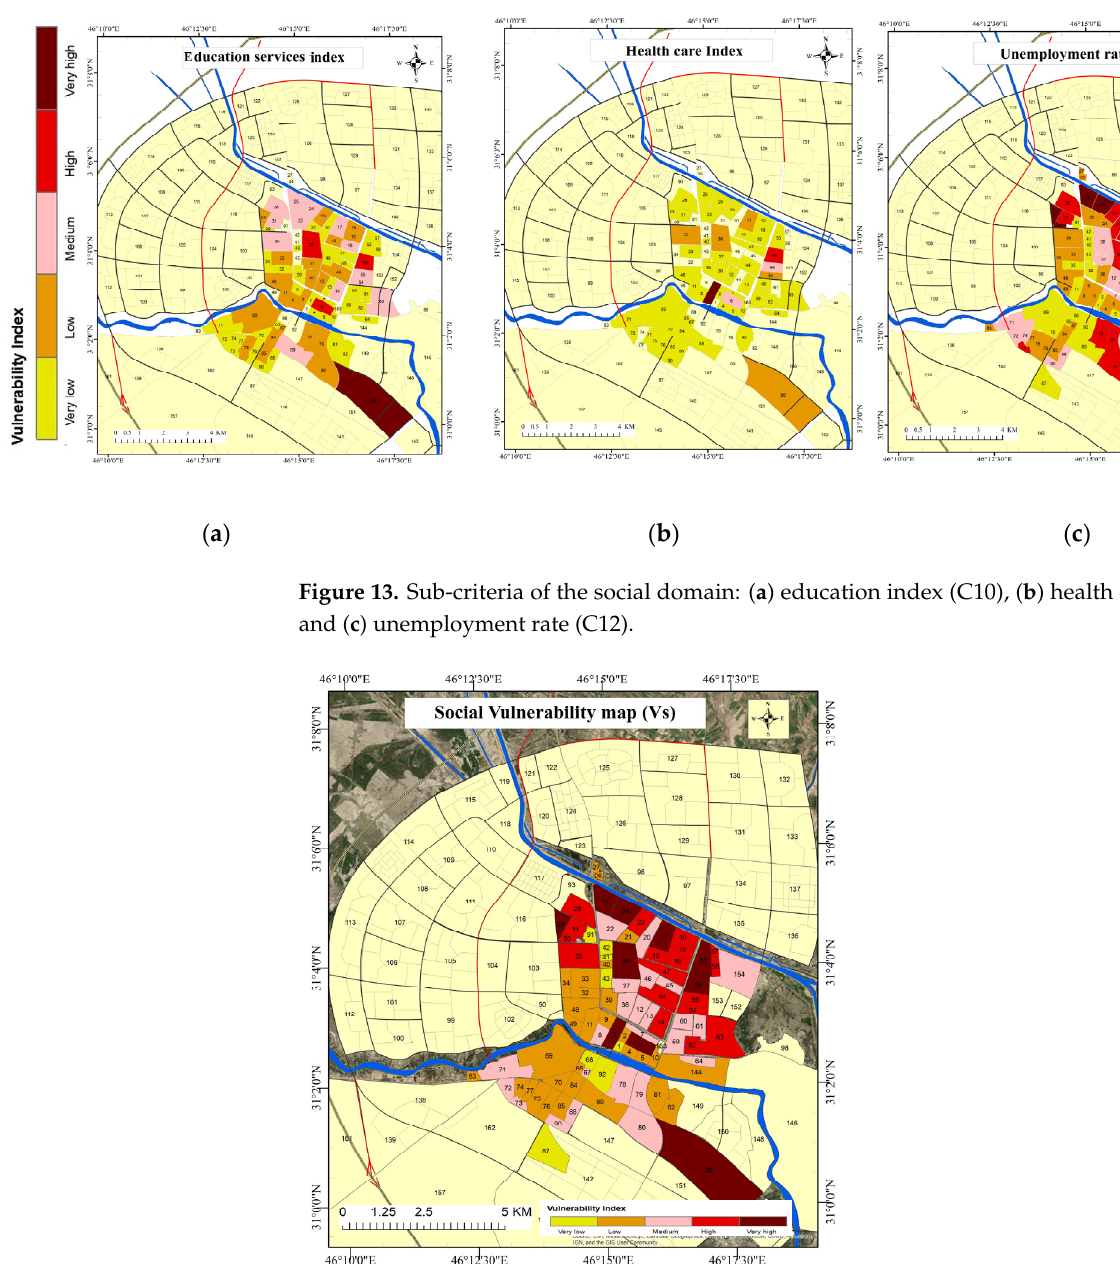
Figure 14. Social vulnerability map (Vs).